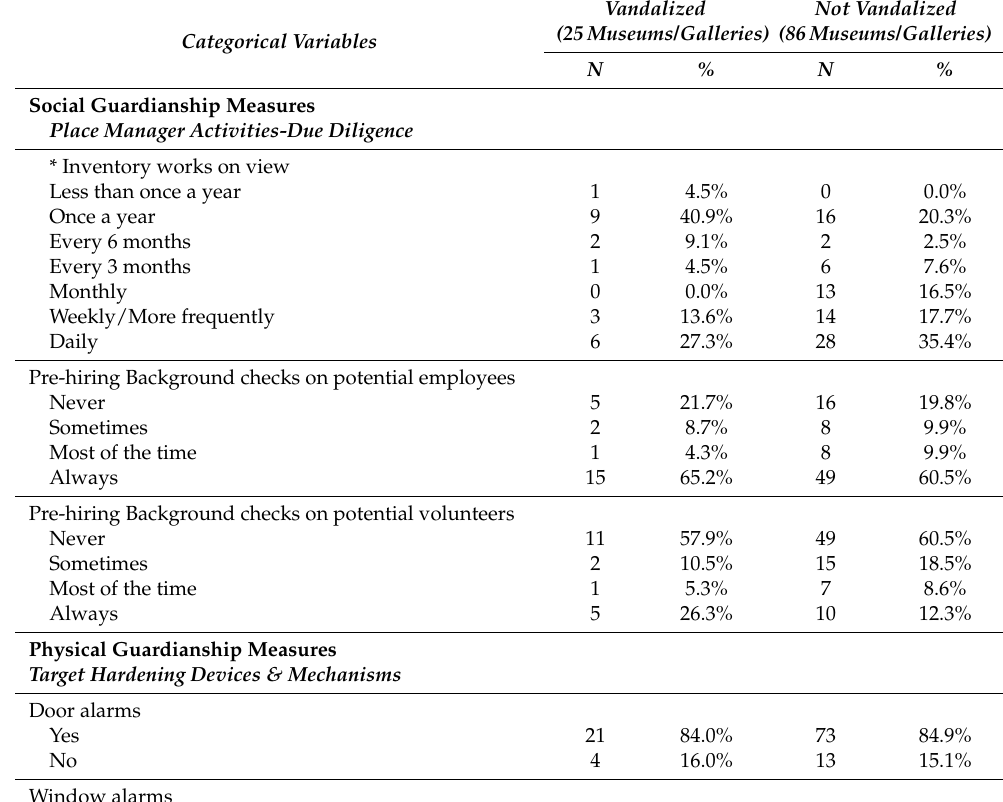
Table 2. Descriptive statistics of museums/galleries that were victimized by art vandalism compared with museums/galleries that were not victimized by art vandalism, categorical